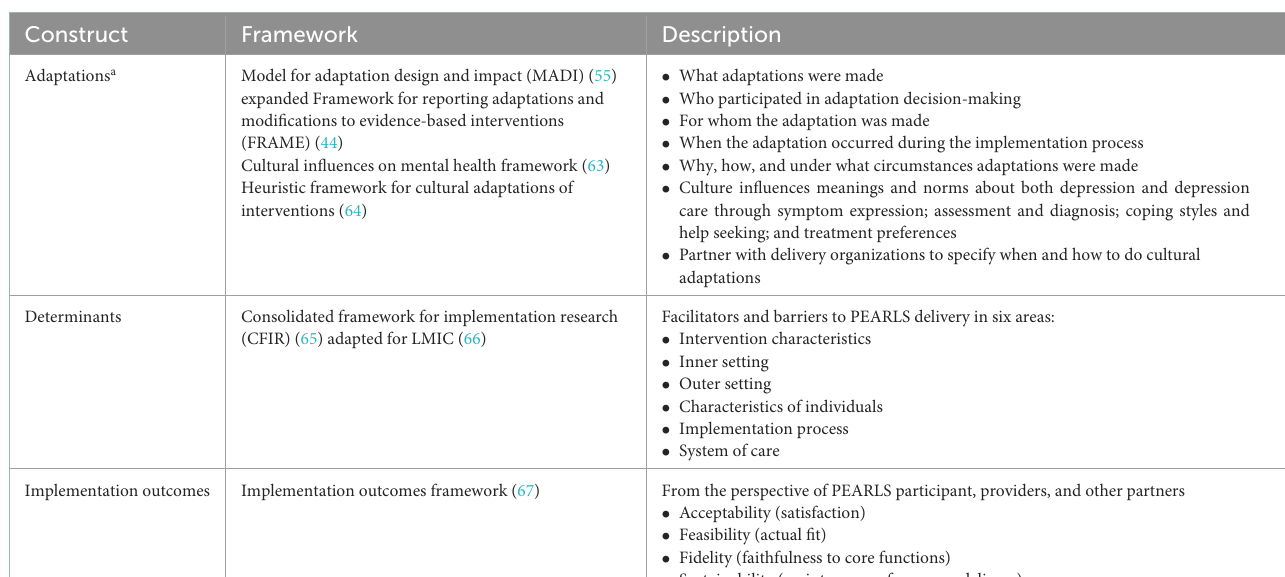
TABLE 2 Theoretical implementation science and cultural adaptation frameworks used for deductive